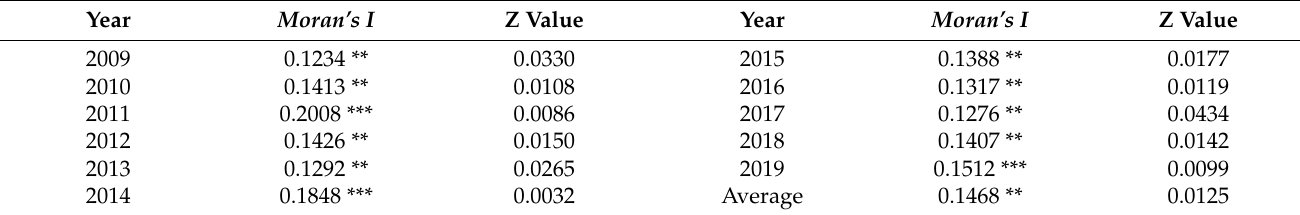
Table 4. Moran’s I of overall EWP during 2009~2019.